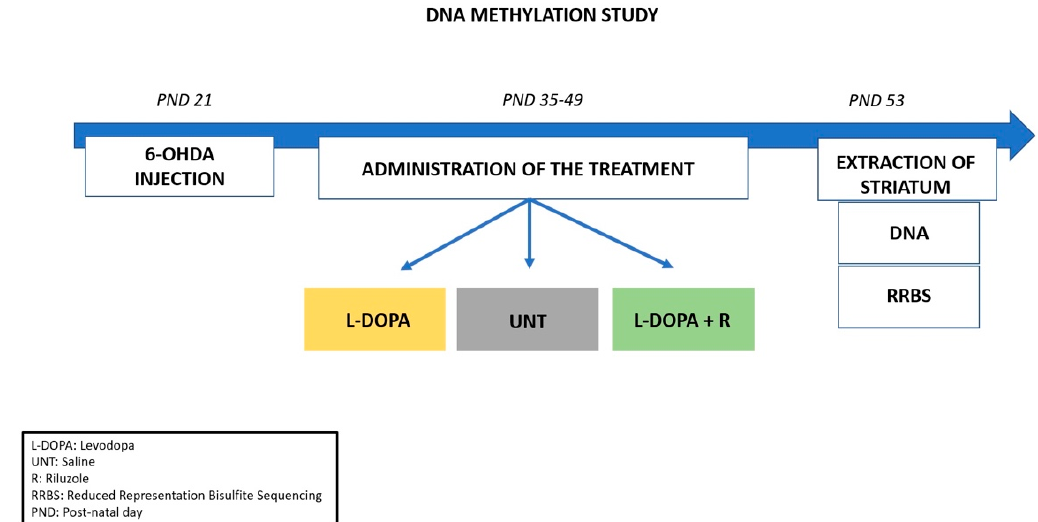
Figure 1. Schematic representation of the experimental workflow. Rats received a unilateral injection of 6-OHDA at PND 21 followed by a 2-weeks sub-chronic treatment (from PND 35 to PND 49) according to their respective group (L-DOPA, UNT, L-DOPA + Riluzole). The rats received one final treatment at PND 53; striata were collected and analyzed for changes in methylation levels.